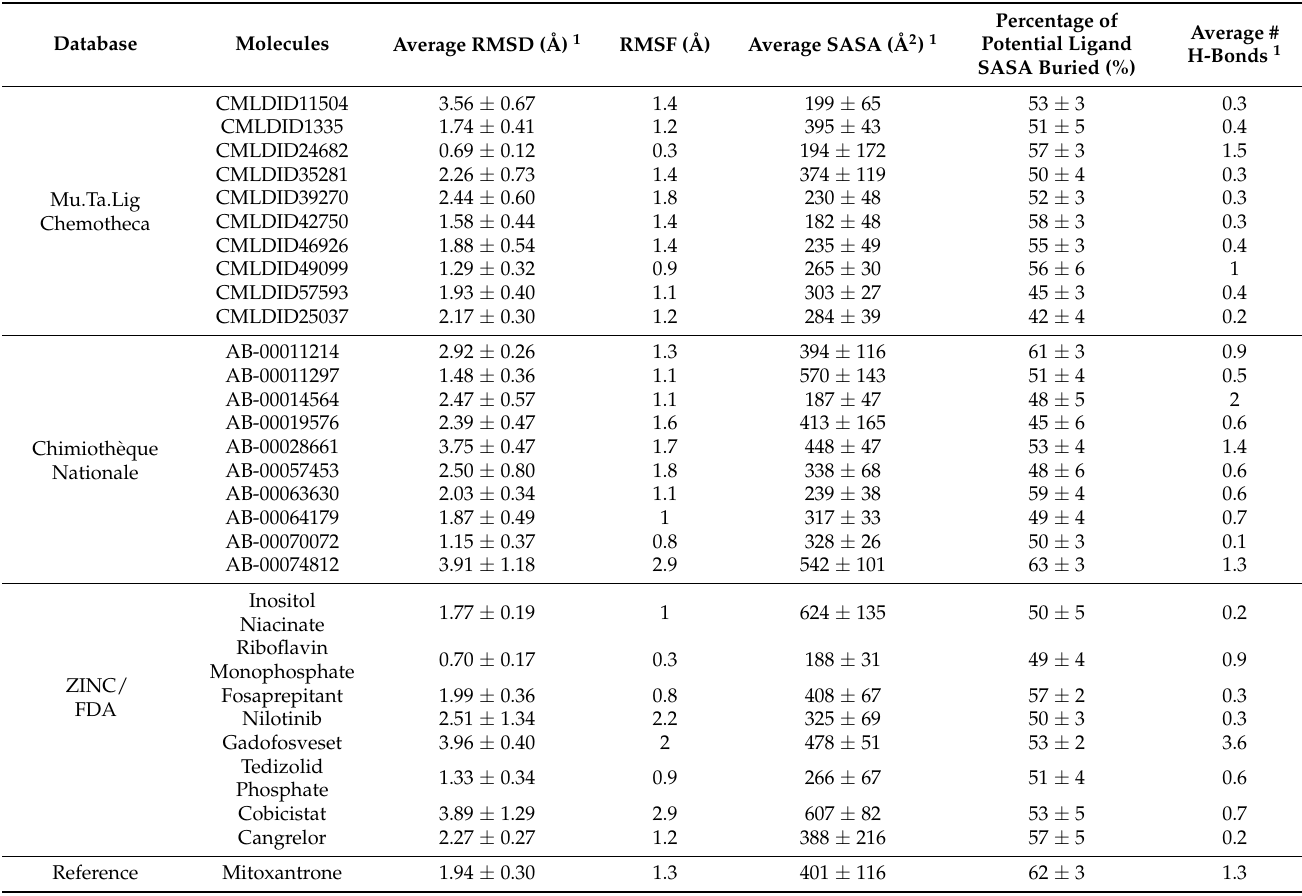
Table 4. Average RMSD values (Å), RMSF (Å), average SASA (Å 2 ), percentage of potential ligand SASA buried and an average number of hydrogen bonds for the ligands for the last 40 ns of the simulation of the PknB–ligand complexes.